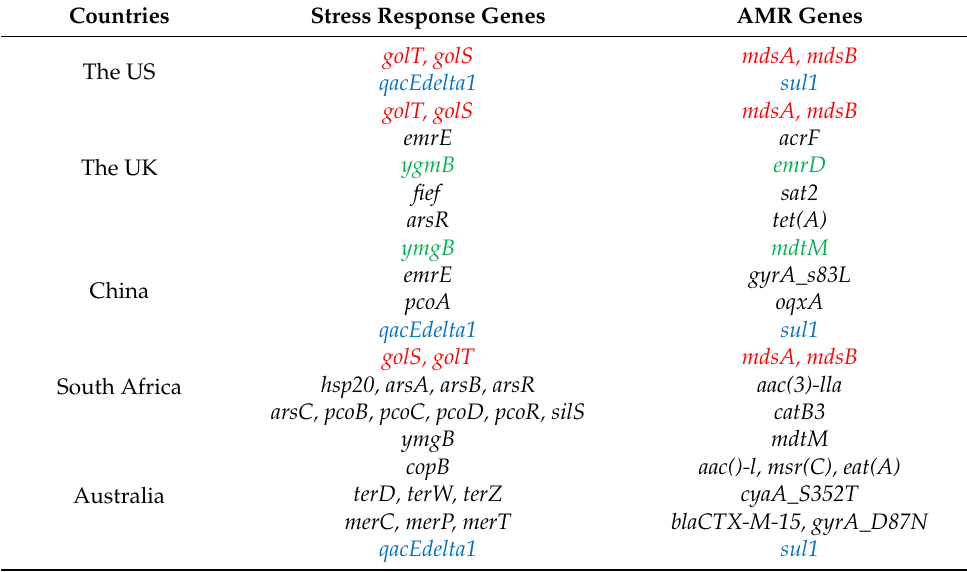
Table 3. The stress and AMR genes that were connected in the hierarchical tree from each country. The pairs of stress response and AMR genes that were detected in multiple countries are marked in